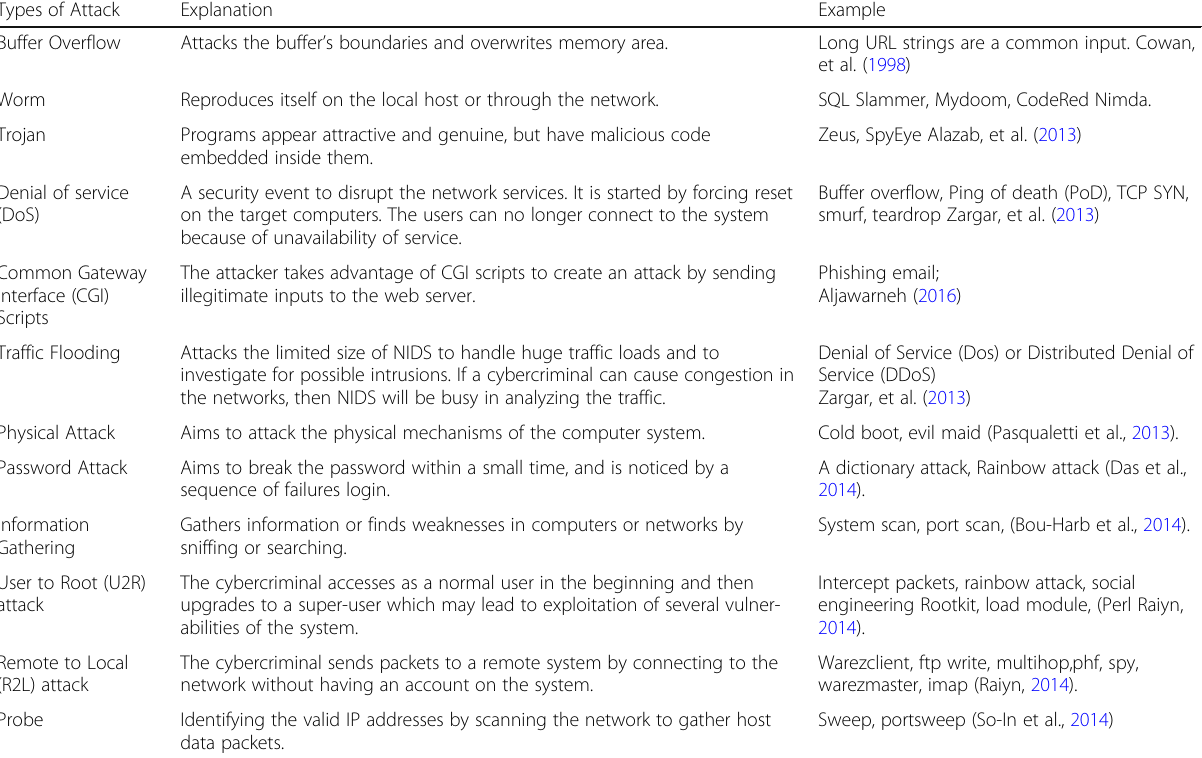
Table 15 Classes of computer